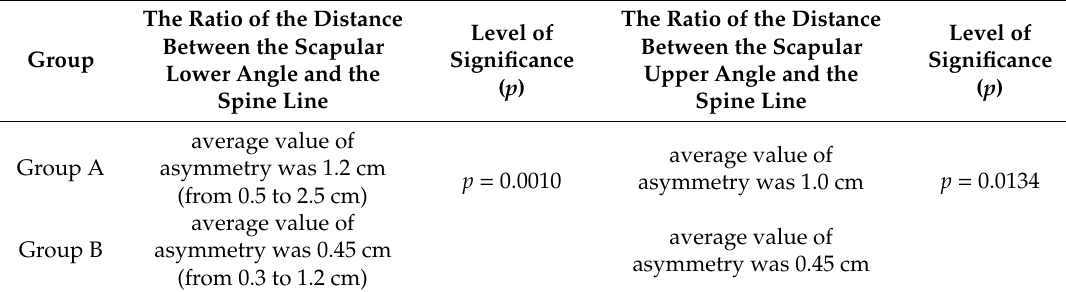
Table 2. Scapular position static assessment.